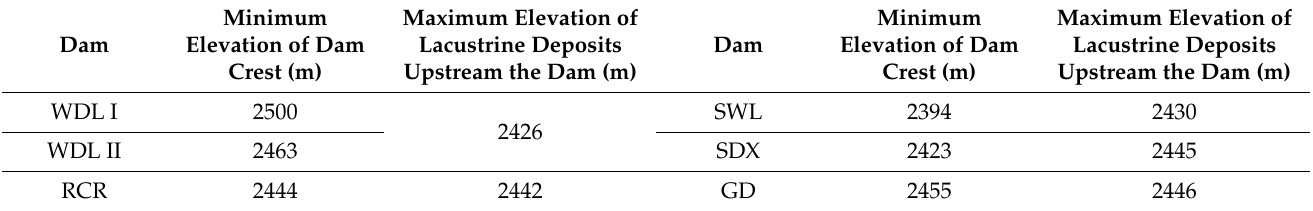
Table 2. Elevation of dam crest and maximum elevation of lacustrine deposits upstream from the